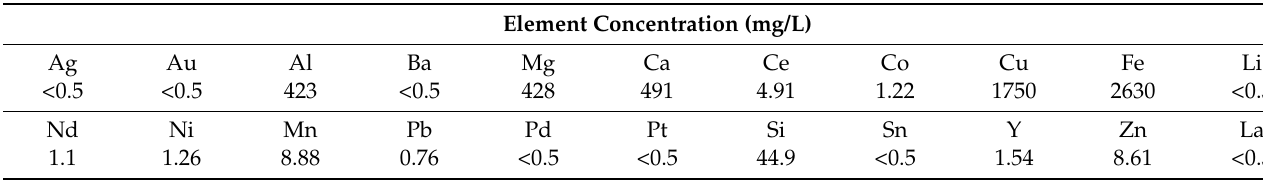
Table 2. Element distribution of acid mine drainage (AMD).